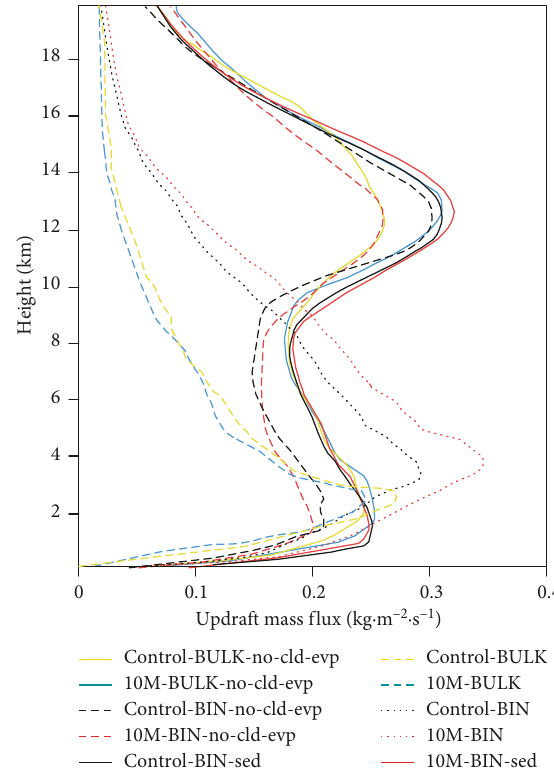
Figure 10: Vertical distributions of the time- and domain-averaged updraft mass fluxes for the simulations in Figure 7(b), the control- BIN-sed run, and the 10M-BIN-sed run.